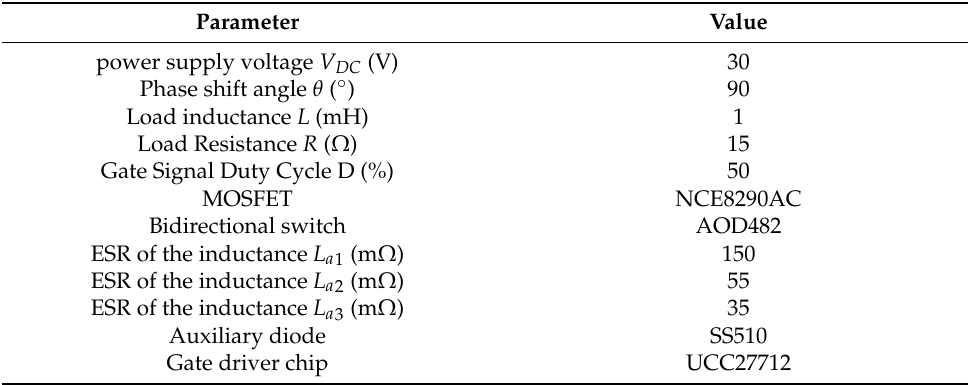
Table 2. Circuit component parameters.